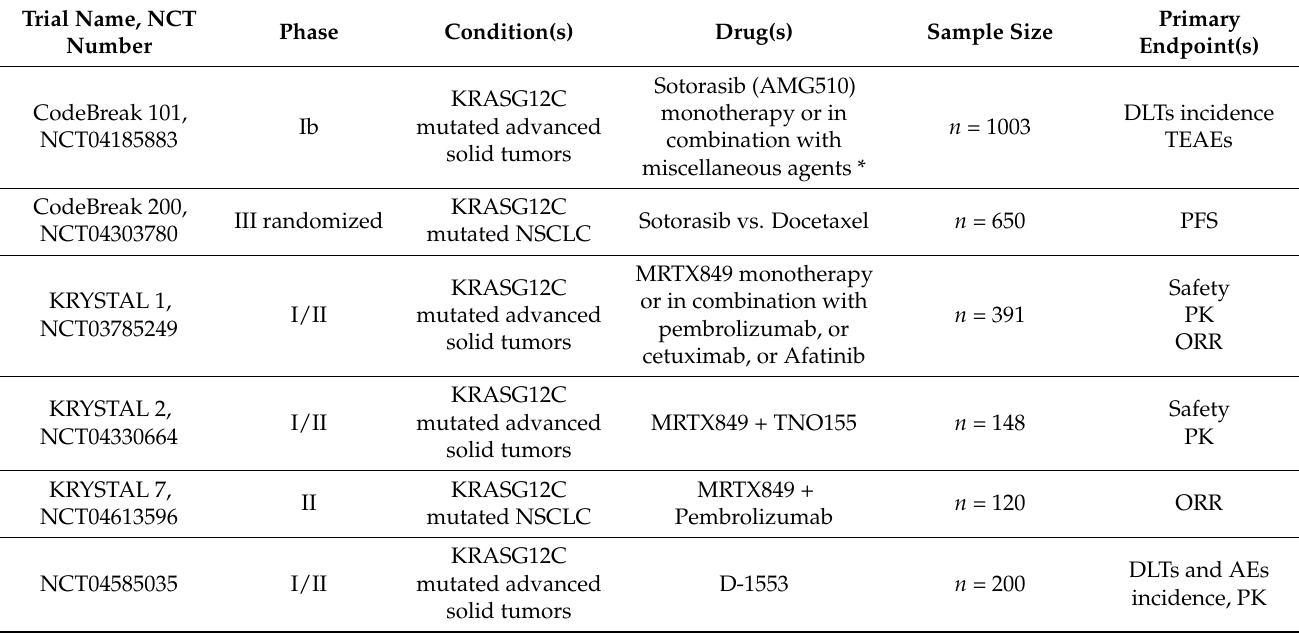
Table 1. Main characteristics of ongoing clinical trials of KRAS inhibitors in KRAS mutated tumors (source: https: //clinicaltrials.gov, accessed on 11 March